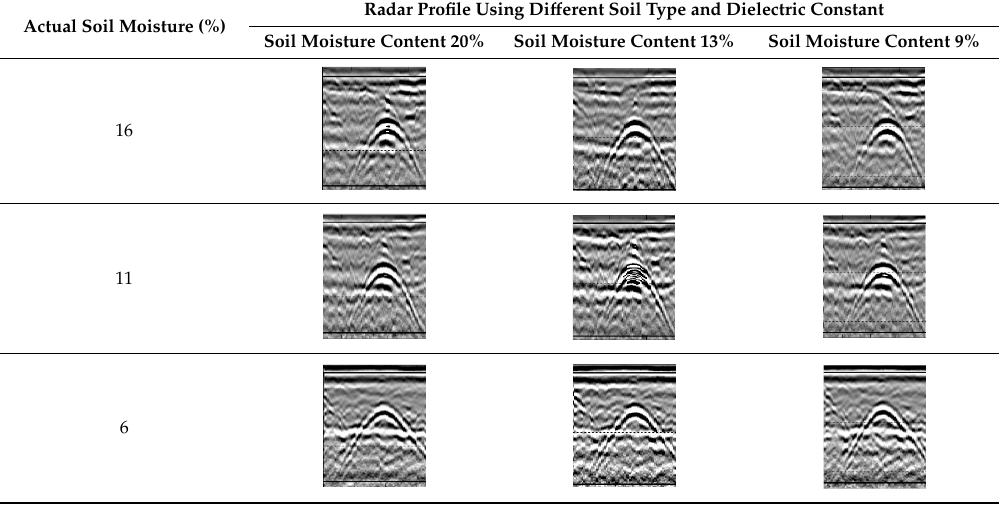
Figure 8. Evaluation of root depth: ( a ) Relationship between the actual depth and the depth measured from the GPR profiles. ( b ) Error of detection with increasing depth.